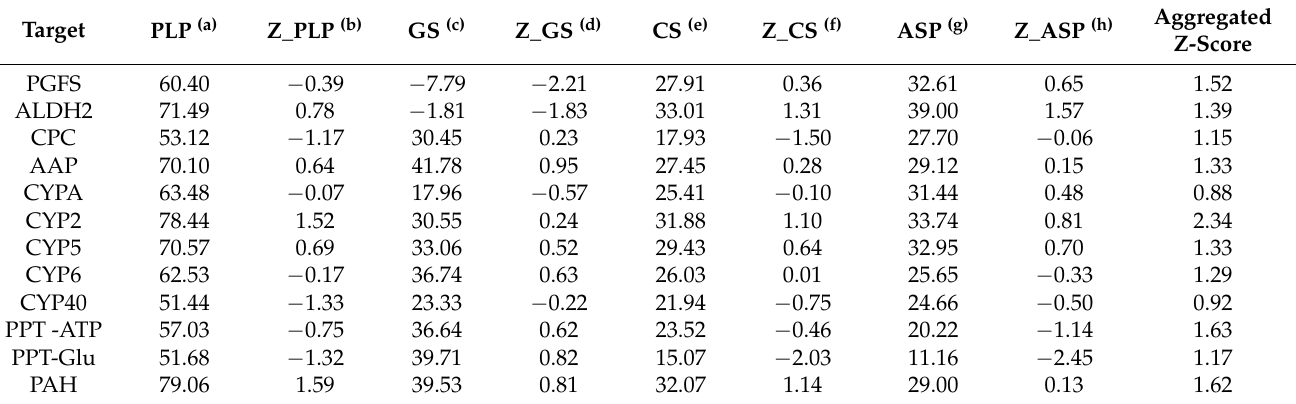
Table 4. Docking scores for the top-scored conformer.